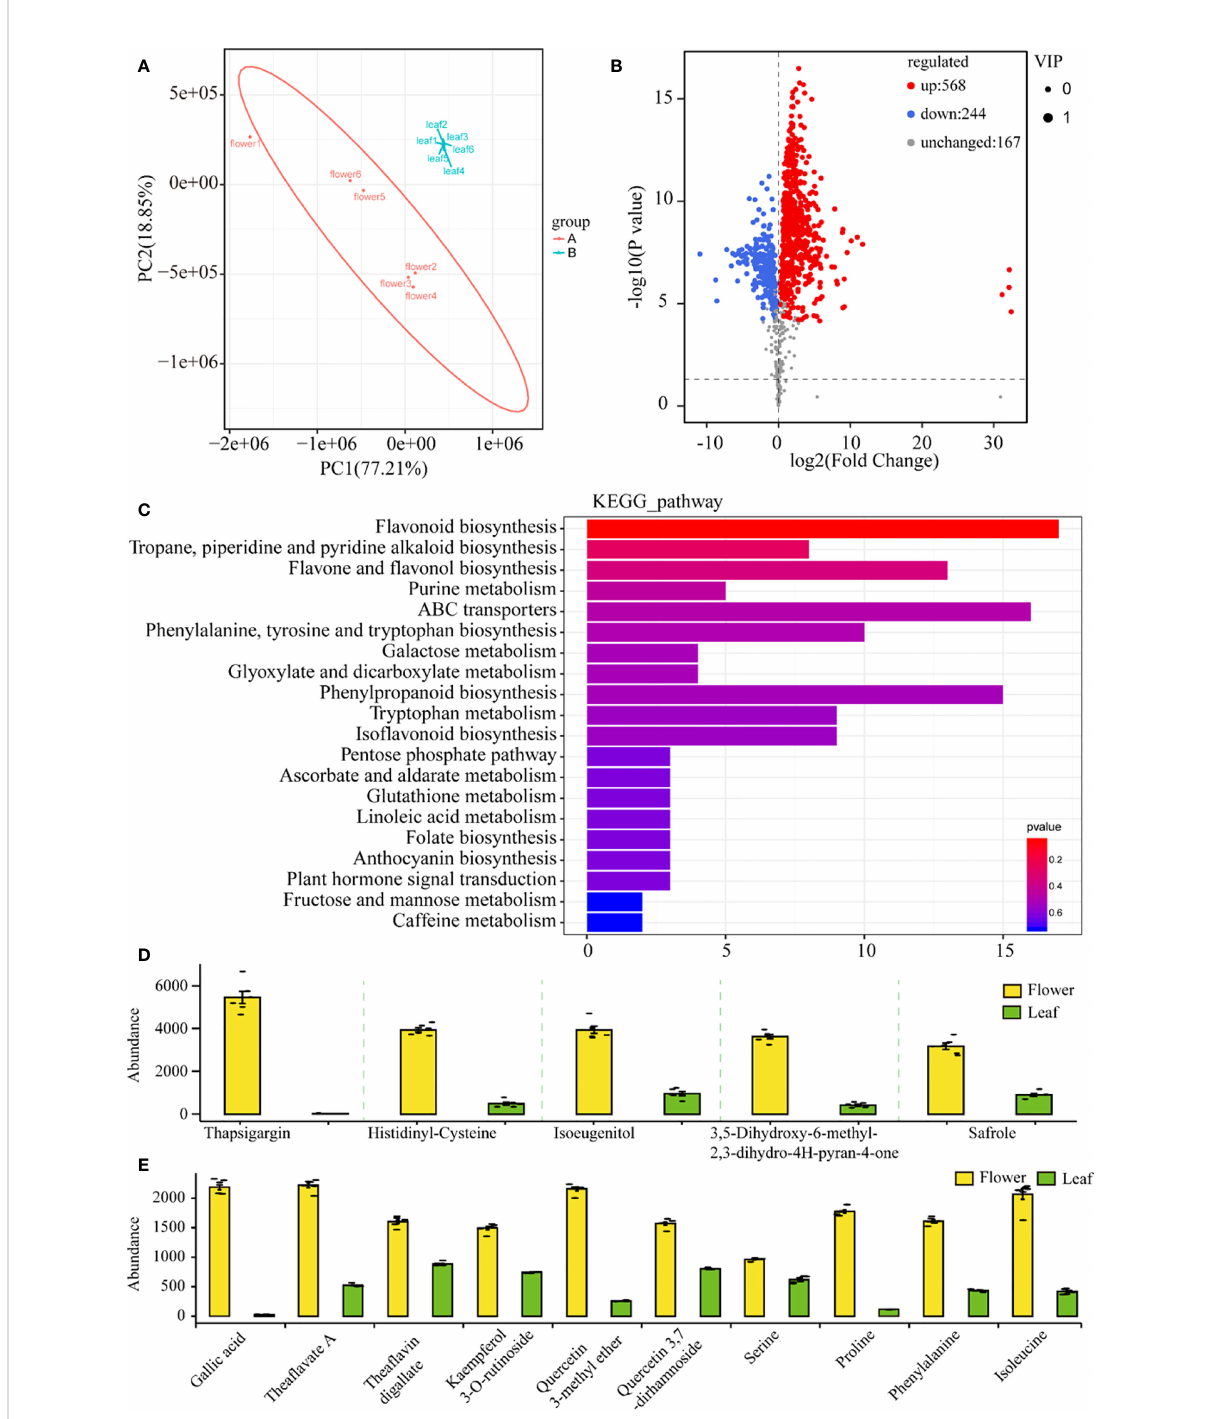
FIGURE 3 Nontarget metabolic analysis of tea fl owers and leaves. (A) Principal component analysis of tea fl ower and leaf samples. PC1, the fi rst principal component. PC2, the second principal component. For each tissue samples, six biological replicates were prepared. (B) Volcano plots of differential metabolites in tea fl ower and leaf samples. (C) Kyoto Encyclopedia of Genes and Genomes pathway enrichment analysis of different metabolites in tea fl ower and leaf samples. (D) Five most abundant metabolites in tea fl owers. (E) Differences in key metabolites between tea fl owers and